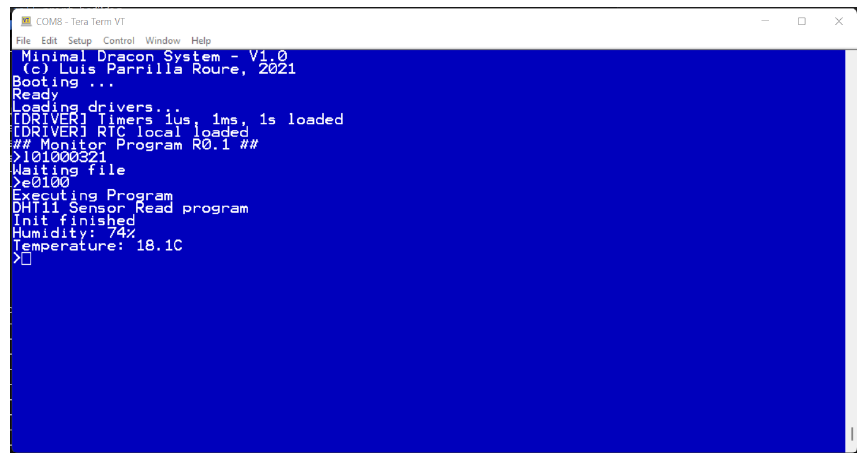
Figure 12. Bluetooth humidity/temperature measurement in Dracon.